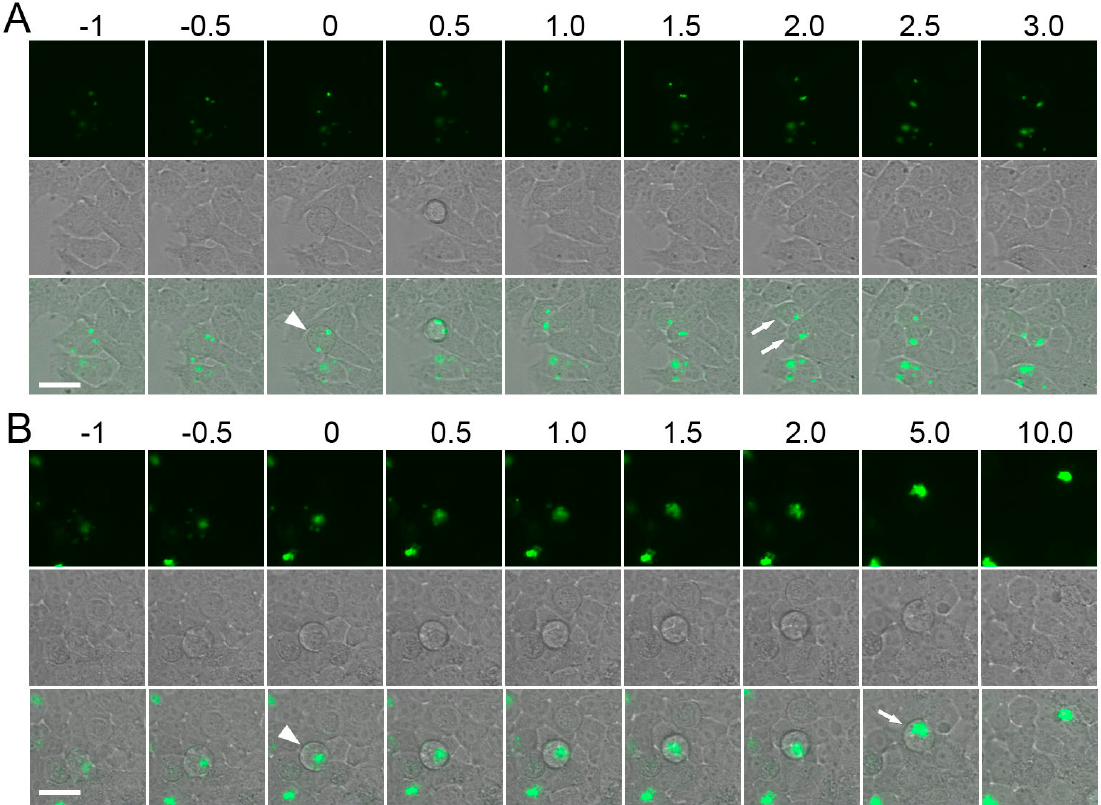
Figure 12. Mitosis in HEK293T cells expressing Trio-AG4. Typical examples of normal ( A ) and abortive ( B ) mitosis are shown. Numbers above the images designate relative time in hours. Upper rows—green fluorescence, middle rows—transmitted light images, bottom rows—overlay (brightness of green signal was enhanced on overlay for clarity). Formation of a rounded mitotic cell carrying fluorescent aggregates is pointed by arrowheads (time 0 h). Note that in ( A ) the cell divided into two daughter cells (two arrows, time 2.0 h), whereas in ( B ) the cell remained rounded for a long time (arrow, time 5.0 h) and did not undergo division. Scale bars, − 30 µm.